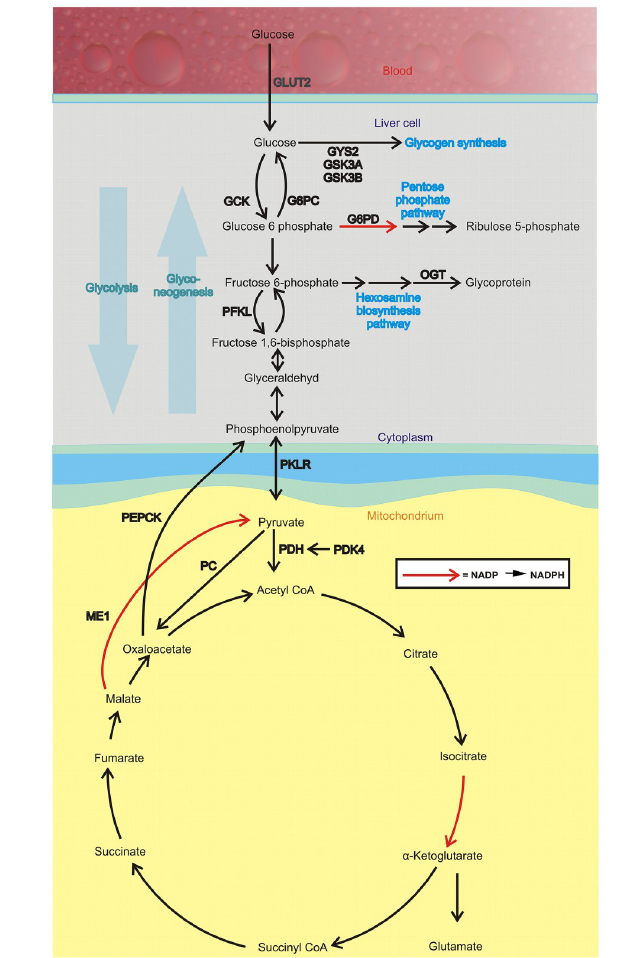
Fig 1. Glucose metabolism pathways in the liver. Abbreviations: glucose transporter 2 (GLUT2/ Slc2a2 ); glucokinase phosphofructokinase ( Pfkl ); pyruvate kinase L/R ( Pklr ); pyruvate dehydrogenase kinase, isoenzyme 2 ( Pdk2 ); pyruvate dehydrogenase kinase, isoenzyme 4 ( Pdk4 ); pyruvate dehydrogenase kinase, isoenzyme 1 ( Pdk1 ); pyruvate carboxylase ( Pc ); glucose-6 phosphatase ( G6pc ); glycogen synthetase 2 ( Gys2 ); Gys3a ; hepatic glycogen synthetase 3 beta ( Gsk3b ); glucose-6-phosphate dehydrogenase ( G6pd ); malic enzyme 1 ( Me1 ); o-linked N-acetylglucosamine transferase (OGT).